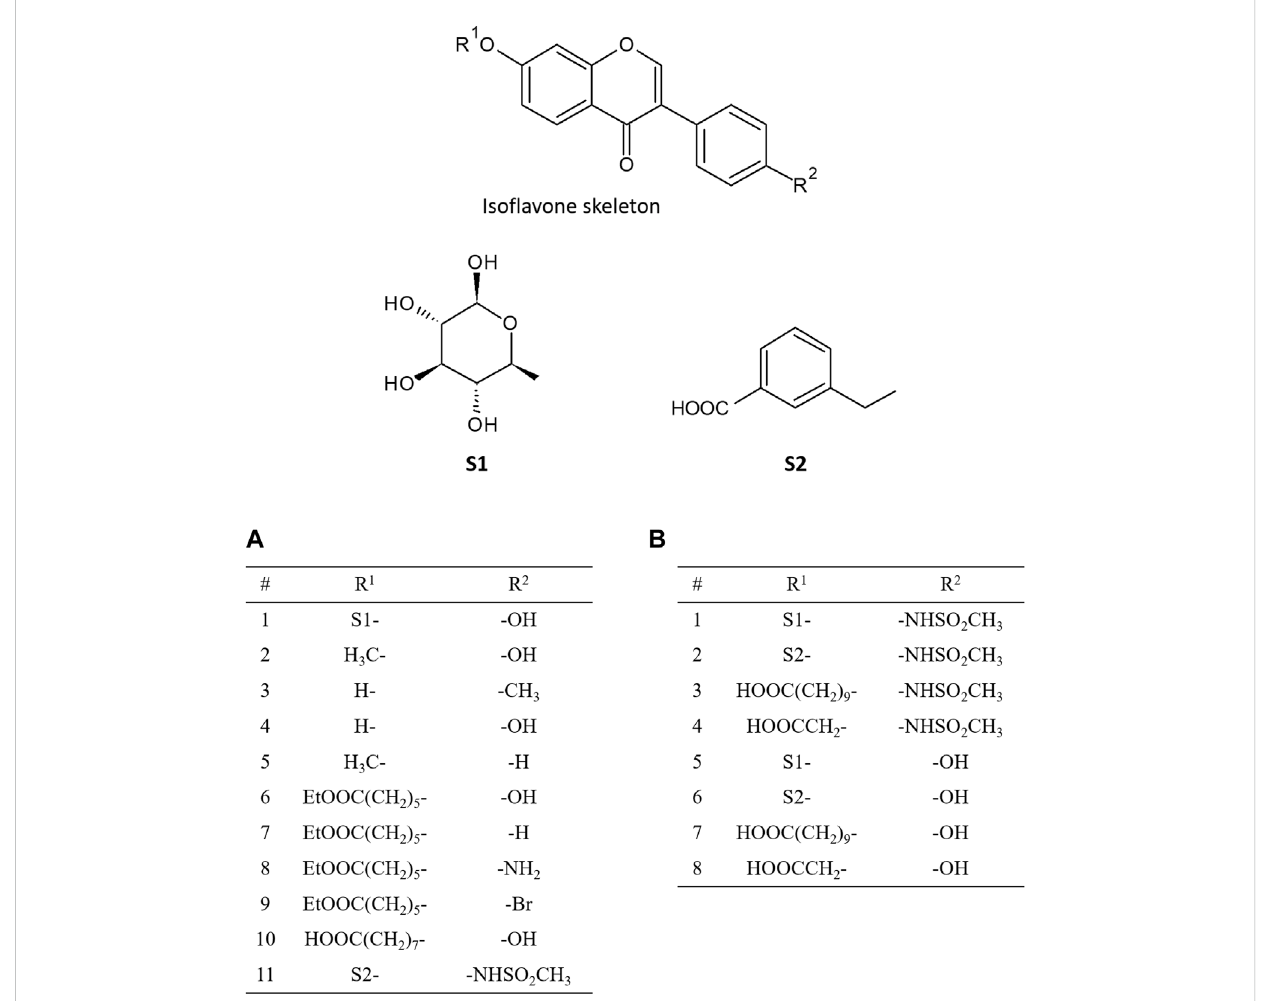
FIGURE 2 Chemical structures of iso fl avone analogues. The substituted groups of daidzin at R 1 and R 2 position are S1- and -OH, respectively, and those of CVT-10216 atR 1 andR 2 positionareS2-and-NHSO 2 CH 3 ,respectively. (A) showsthefunctionalgroupsofiso fl avoneanaloguesaddressedinthepaperby Ferreira and Fraga (2016), and (B) shows the functional groups addressed in the paper by Zhang et al.